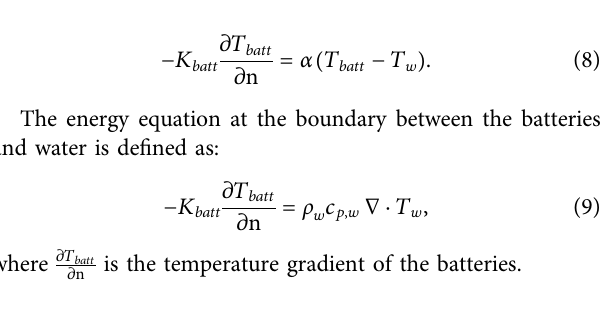
FIGURE 8 | Temperature contours of the battery pack: (A) at 2 C discharge and 100 ml/min cooling rate; (B) at 2 C discharge and 500 ml/min cooling rate; (C) at 3 C discharge and 100 ml/min cooling rate; (D) at 3 C discharge and 1,000 ml/min cooling rate.